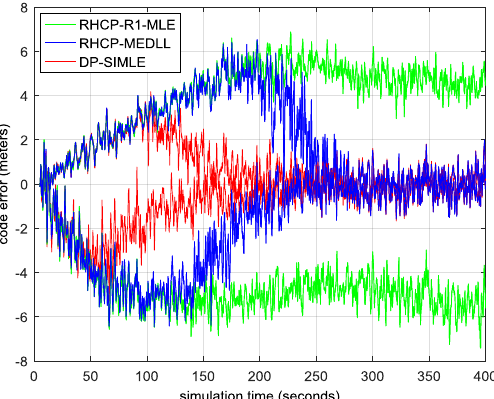
Figure 10. The residual multipath error of the three multipath mitigation algorithms. MP1 shifts 1 m every 10 s, so we can divide the scale of x axis by 10 to obtain the true path delay of MP1 relative to the LOS signal conveniently.